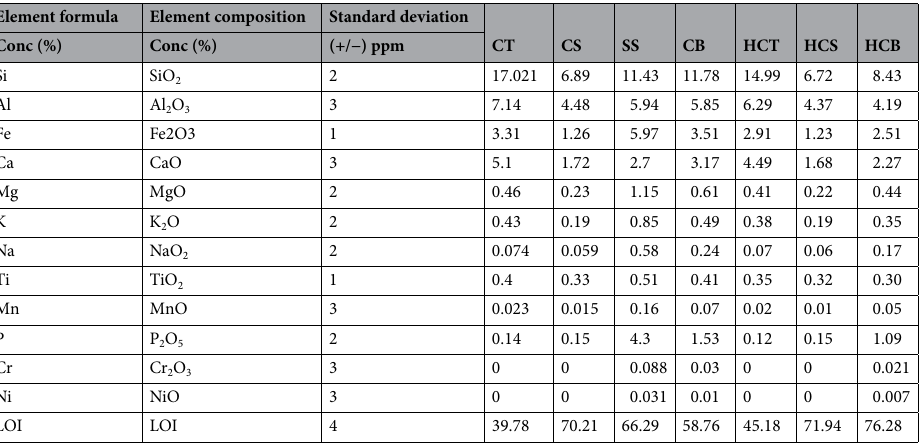
Table 9. XRF results of HC products. CT coal tailing, CS coal slurry, SS sewage sludge, CB blend of coal and sewage sludge, HCT hydrochar from coal tailing, HCS hydrochar from coal slurry, HCB hydrochar from the Blend (SS + CS + CT), C:0.5(CT +